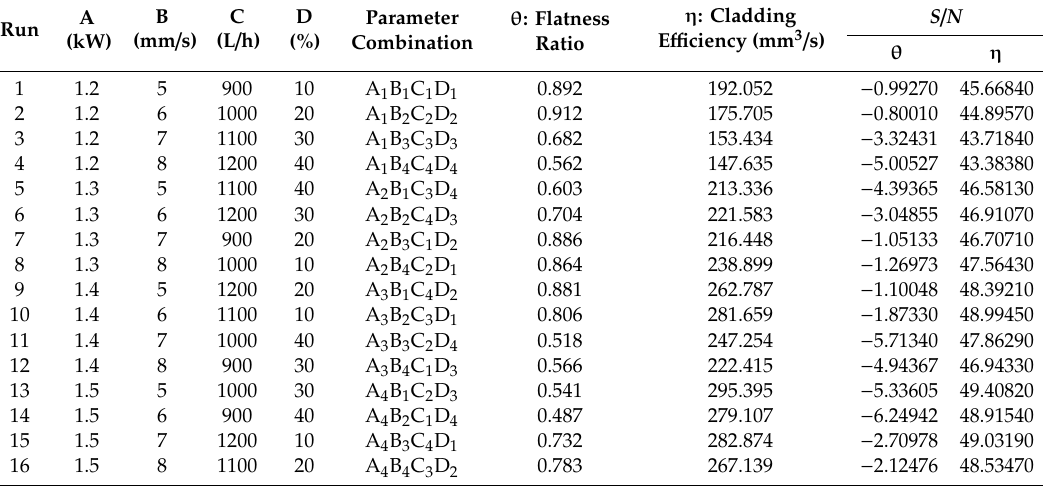
Table 3. Parameter settings in orthogonal experimental design, responses, and corresponding signal–to–noise (S / N) conversion of each run.